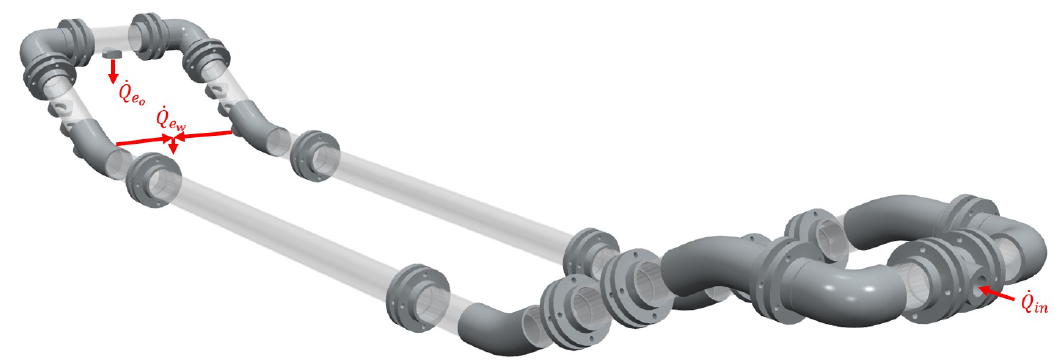
Figure 1. The Multiple Parallel Pipe Separator (MPPS) prototype.